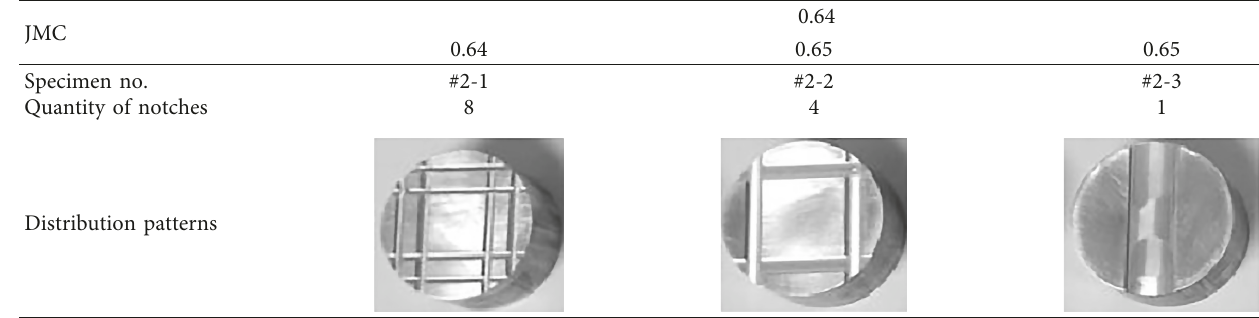
Table 3: Geometrical parameters of the specimens: #Set 2.